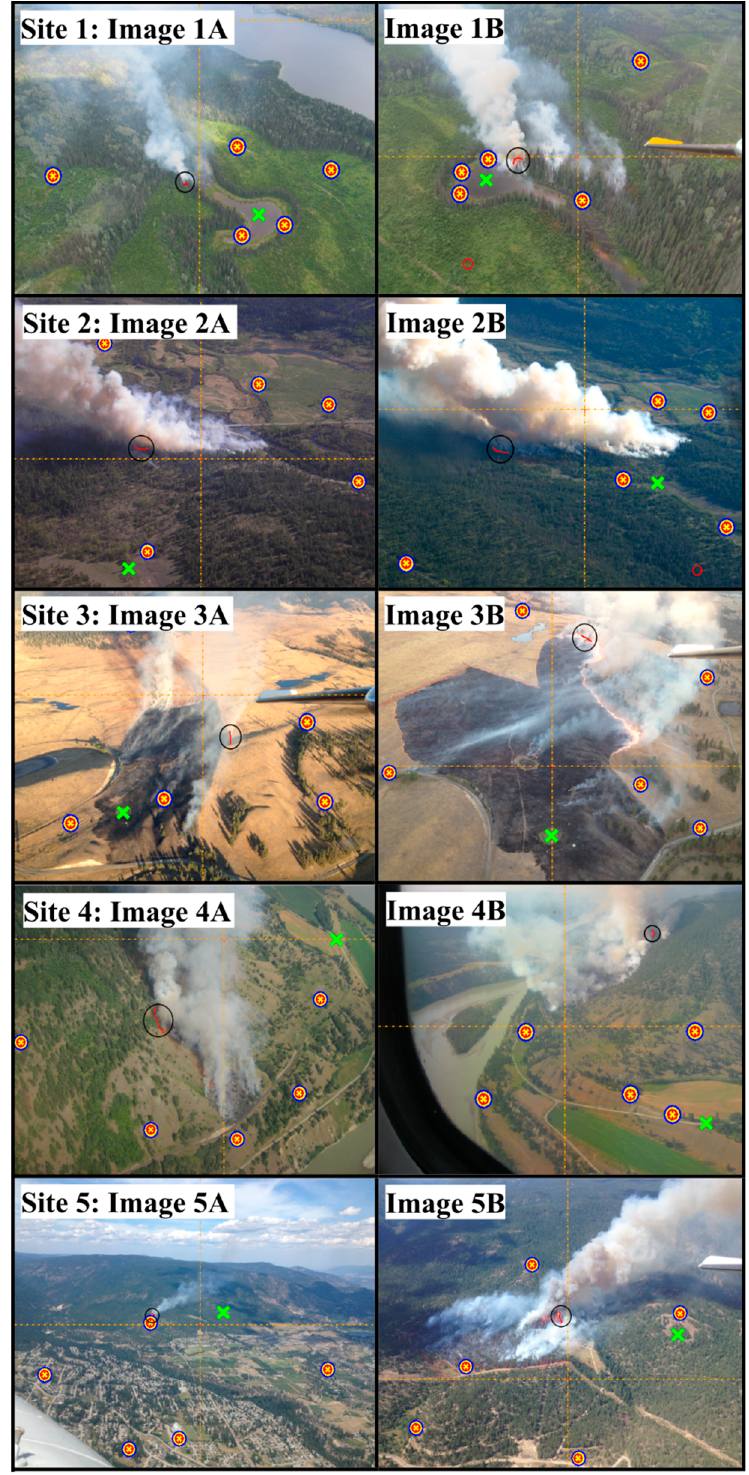
Figure 7. Georeferenced photographs, with identified GCPs (targets), fire front positions (red line in black circle) and green ‘X’ representing a reference feature visible in both images. The mean and maximum 3D error of each of the five image pairs were all under the initial requirement of less than 5 m indicating successful georeferencing. Six of the images also met the angle error target of less than 0.01 ◦ , with the remaining four images not exceeding 0.014 ◦ , which we considered to be within a reasonable